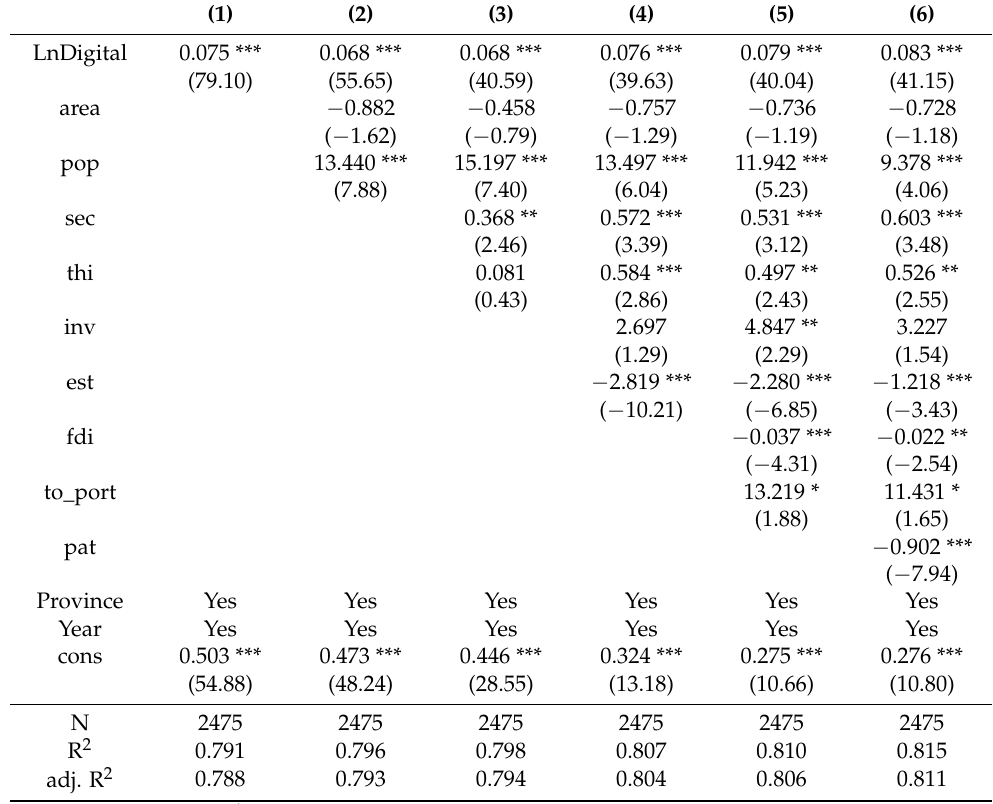
Table 6. Influence of Digital-Economy Degree on Regional Green